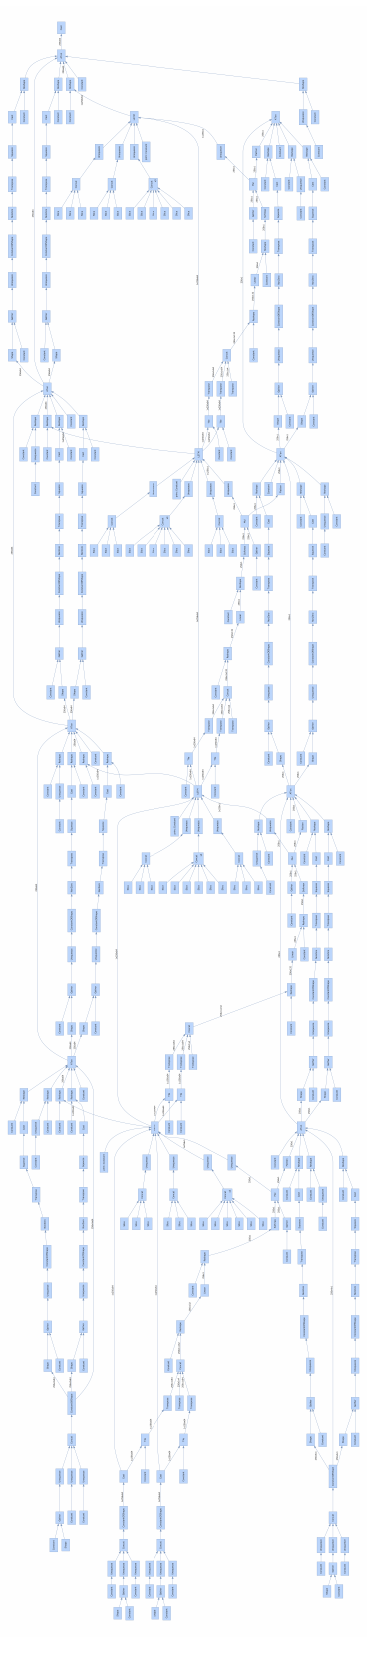
Figure 4. The neural network structure of the decoder of